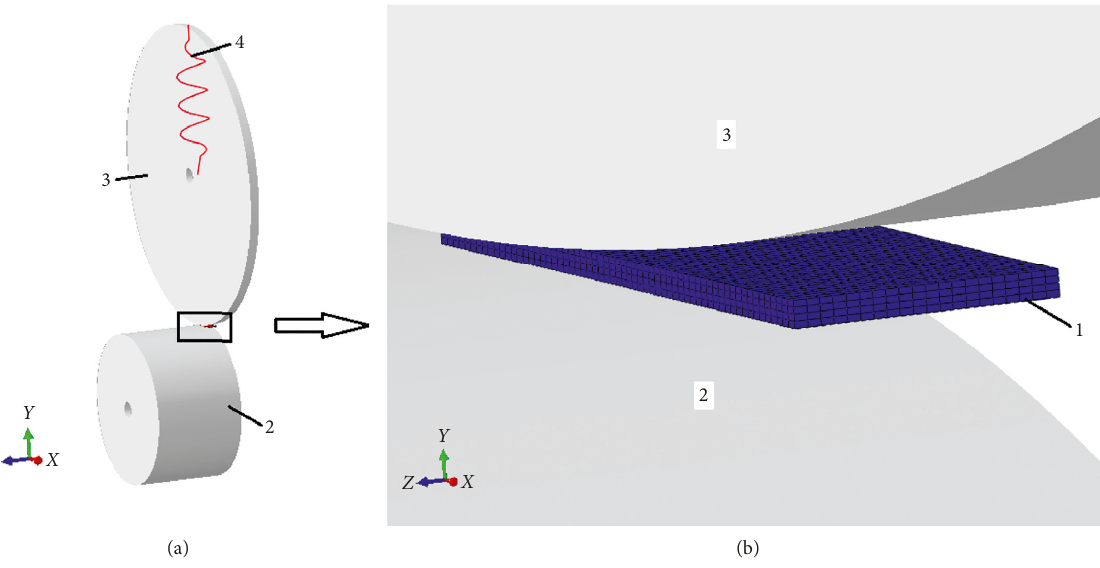
Figure 1: Design model of the finite element modulation of the electrocontact surfacing of cylindrical parts by the tape.1, electrode tape; 2, cylindrical part; 3, roller electrode; 4, elastic element simulating the clamping force of the roller electrode.